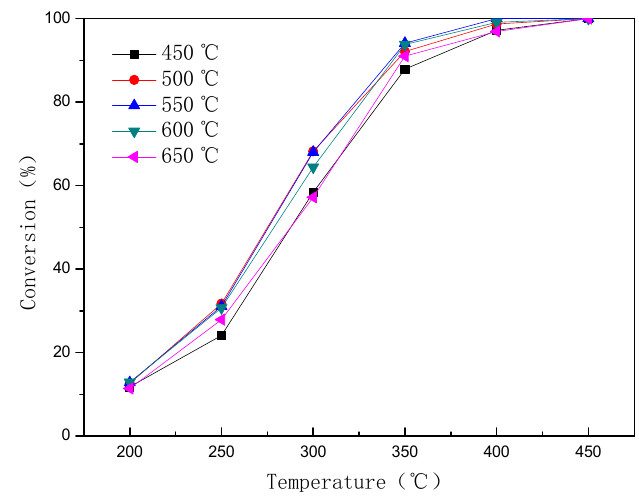
Figure 6. Catalytic oxidation activity of CB using catalysts prepared at di ff erent calcination temperatures. CB concentration = 2500 mg / m 3 ; GHSV = 30,000 h − 1 ; catalyst amount = 2 g.